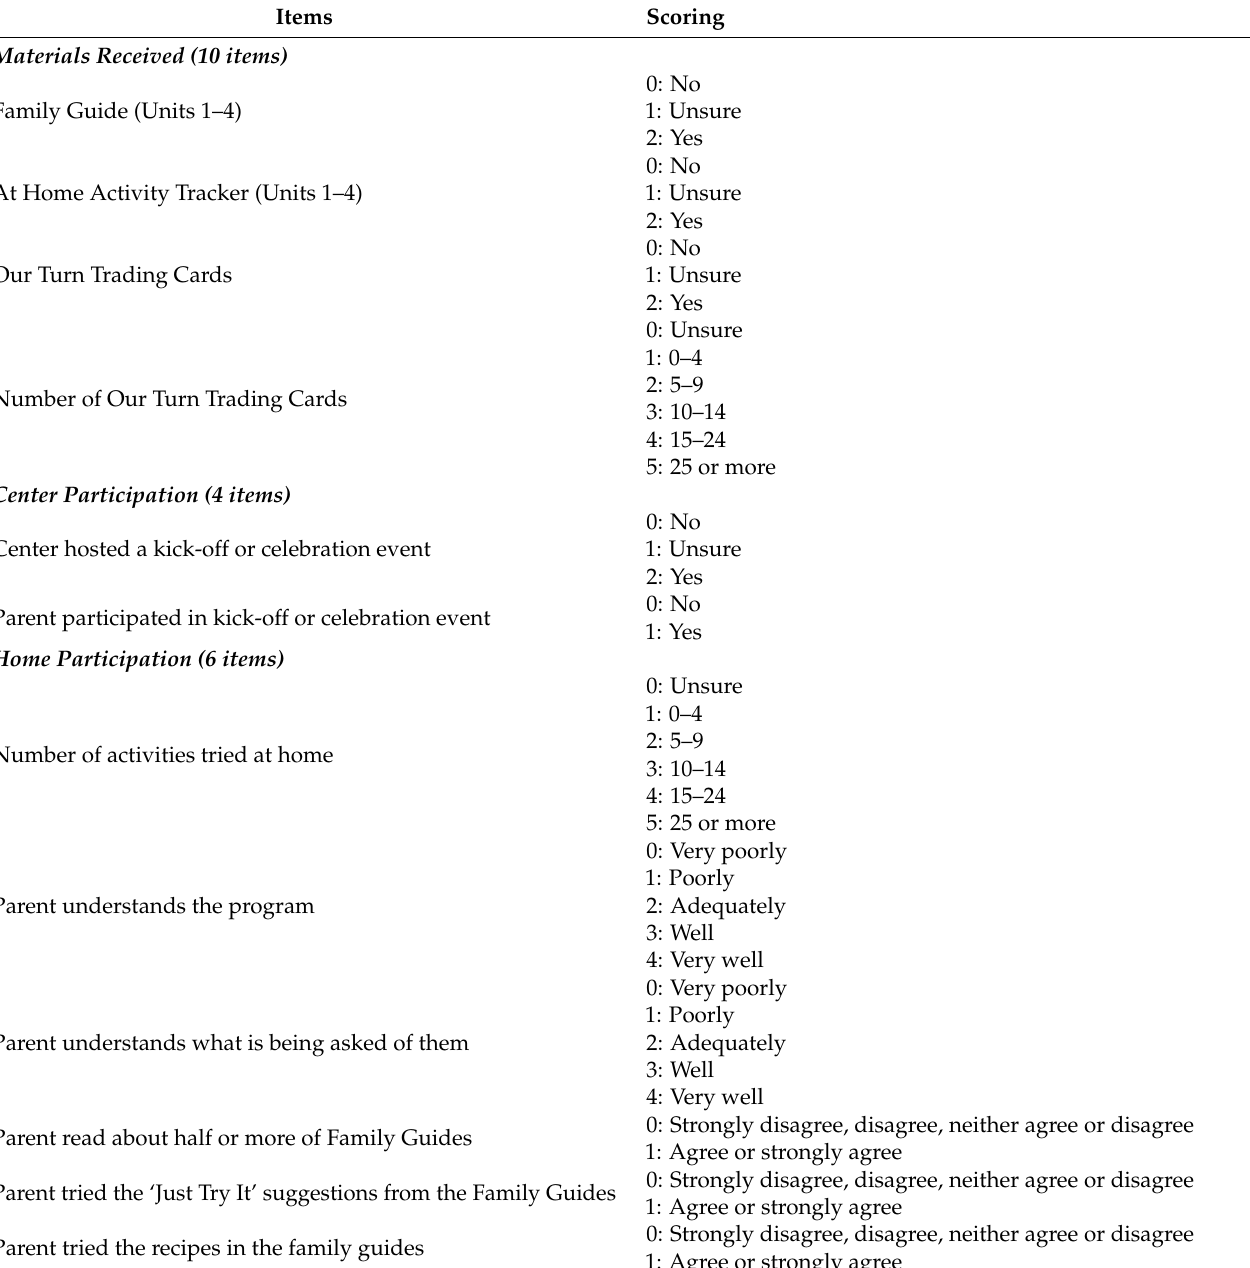
Table 3. Parent-level measure and scoring of parent engagement for Healthy Me, Healthy We from surveys completed after the intervention